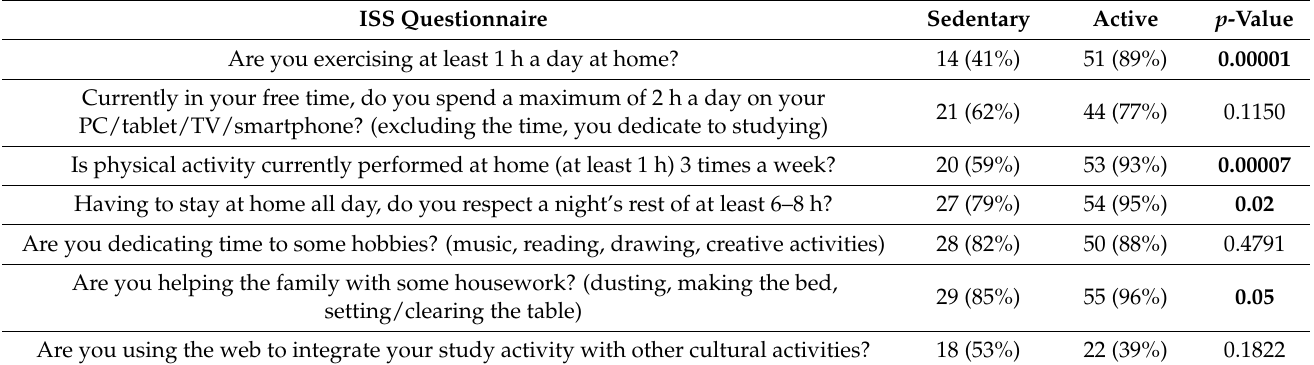
Table 4. Percentages (%) of sedentary and active adolescents during lockdown with respect of items from the ISS questionnaire. ISS Questionnaire Sedentary Active p -Value Are you exercising at least 1 h a day at home?